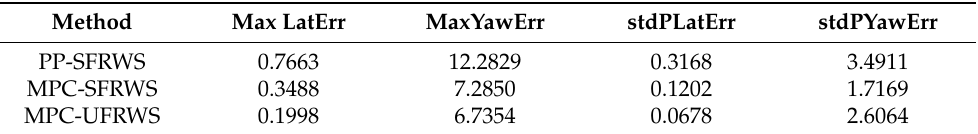
Figure 11. Results of different methods in vehicle experiments. ( a ) Trajectory tracking; ( b ) Lateral error; ( c ) Heading error; ( d ) Steering angle. Table 2. Result data of vehicle